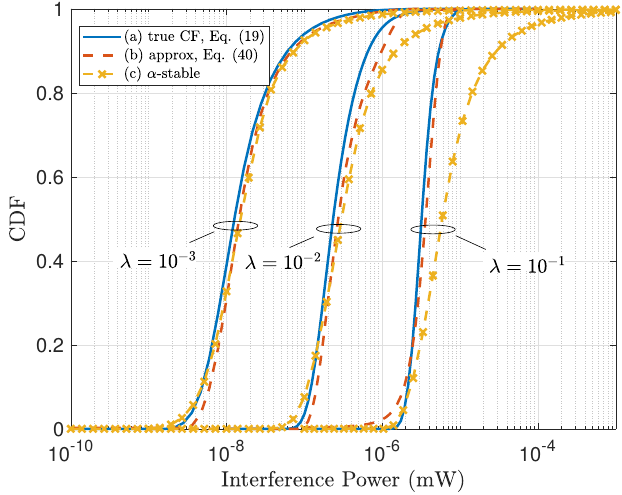
Figure 12. Comparison of the CDF of the aggregated interference power, within R max = 400 m using a UCA of size N c = 16 positioned at AP height h = 2 m, for different interferer density λ = { 10 − 3 ,10 − 2 ,10 − 1 } m − 2 , path-loss exponent 2 b = 2.6, transmit power [ P tx ] dBm = 20 dBm, central √ P tx 4 π F c / c , for three cases: (a) true CF model described in (19); frequency F c = 28 GHz and | β o | = (b) approximate mixture model described in (40); and (c) α -stable